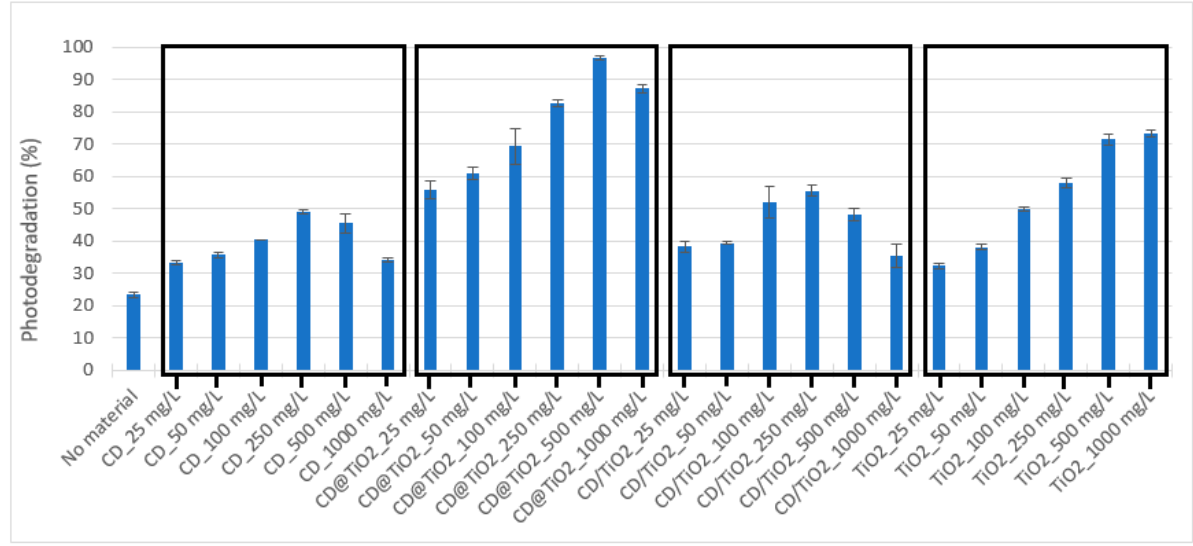
Figure 6. SDZ (10 mg L − 1 ) photodegradation (%) after 4 h of simulated solar radiation in the absence and presence of photocatalysts at concentrations ranging from 25 to 1000 mg L − 1 . Note: Error bars represent standard deviations ( n = 3).